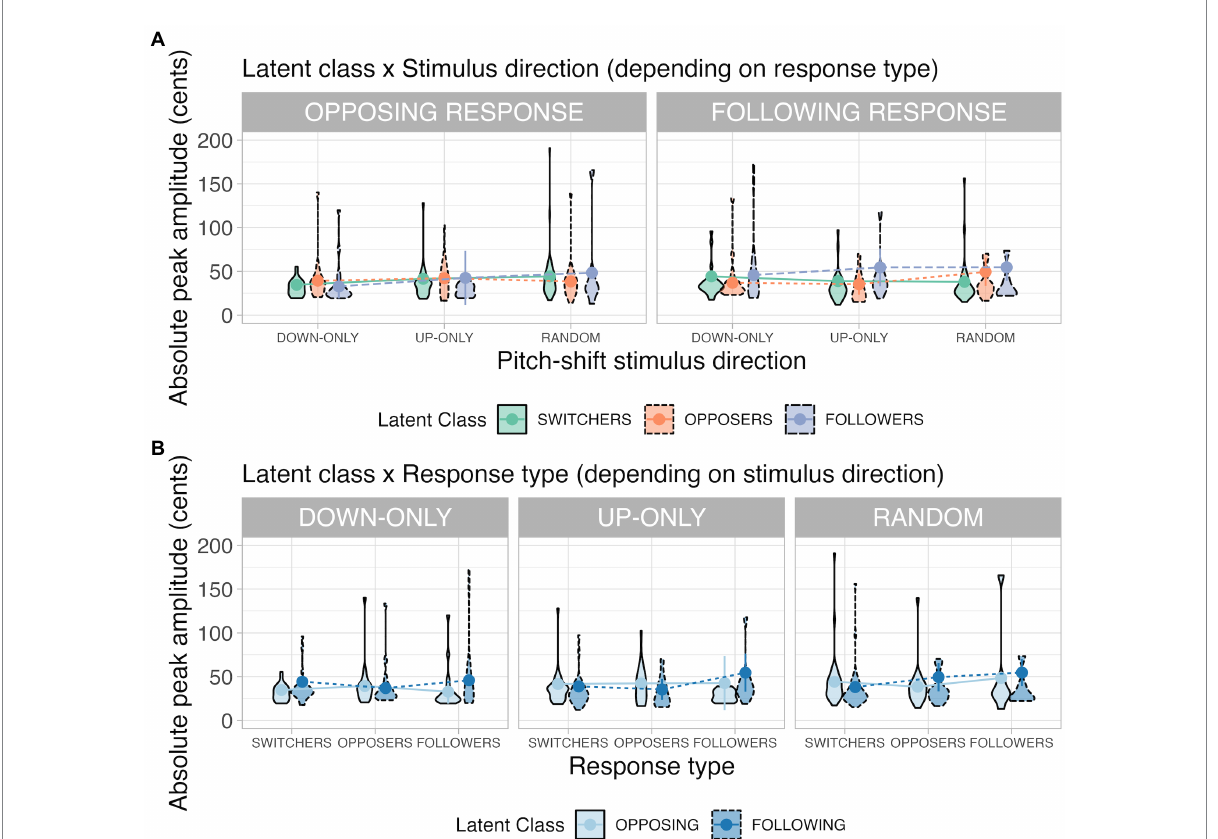
FIGURE 5 Violin plots illustrating the latent class × stimulus direction interaction (Panel A ) and the latent class × response type interaction (Panel B ) for the response peak amplitude. Definitions for the violin plots: Means superimposed with error bars are connected by lines, violin shapes extend to 1.5 times the interquartile range, and widths of the violin shapes represent density